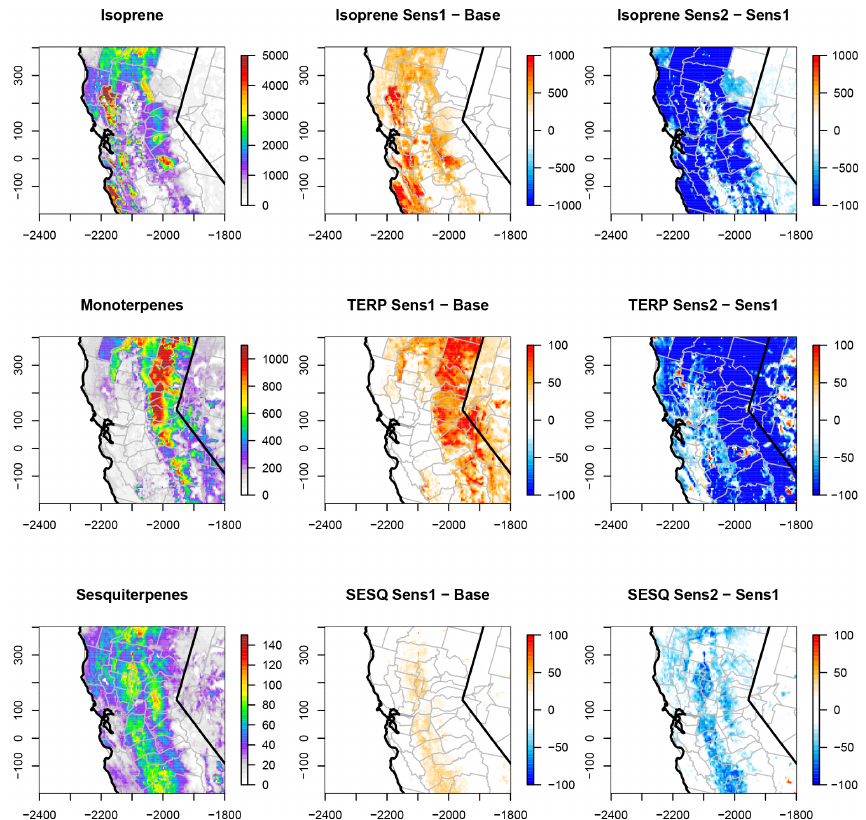
Figure 5. Baseline BEIS 3.14/BELD 3 emissions (tons; left column) and difference between canopy update and baseline BEIS 3.61/BELD 3 (center column) and between the canopy update and land use/vegetation species updates BEIS 3.61/BELD 4 (right column).